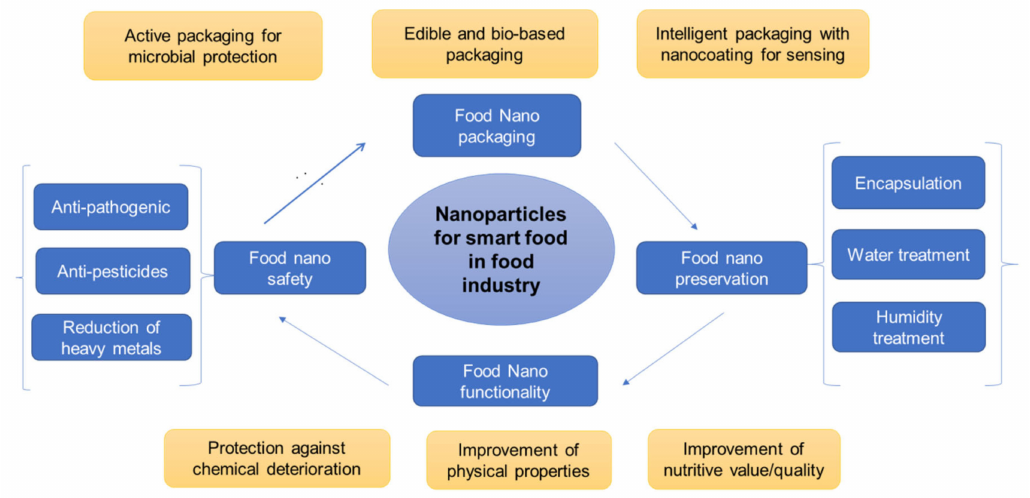
Figure 3. Summary of some applications of nanoparticles for developing smart food in the food